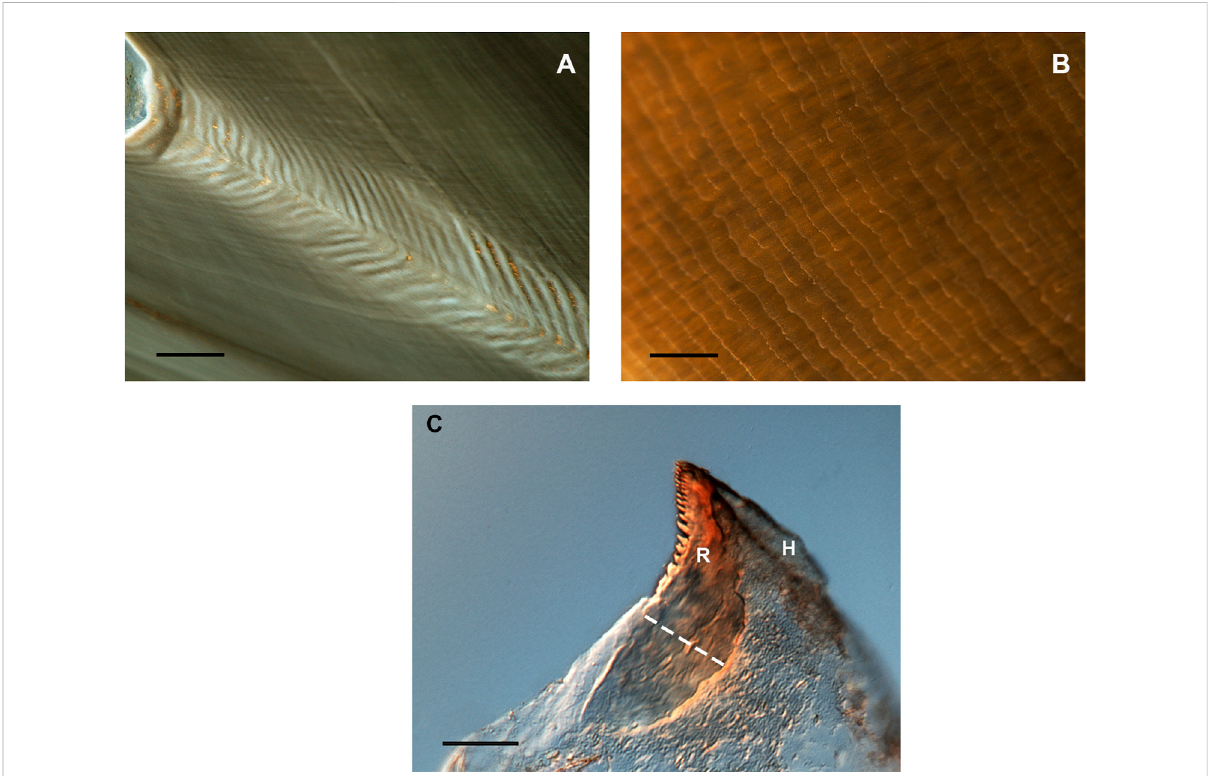
FIGURE 4 Microstructure of beaks showing growth increments in cephalopod beaks ( Octopus vulgaris ). (A) Increments in the rostrum sagittal sections (RSS).Bar:100 µm. (B) Incrementsintheinnerlateralwallsurfaceoftheupperbeak.Bar:200 µm. (C) Incrementsintherostrumsurfaceoftheupper beak in early stages. R = rostrum; H = hood; dotted white line = reading area. From Arkhipkin et al. (2018) and Perales-Raya et al. (2018); copyright permission obtained). Bar: 50